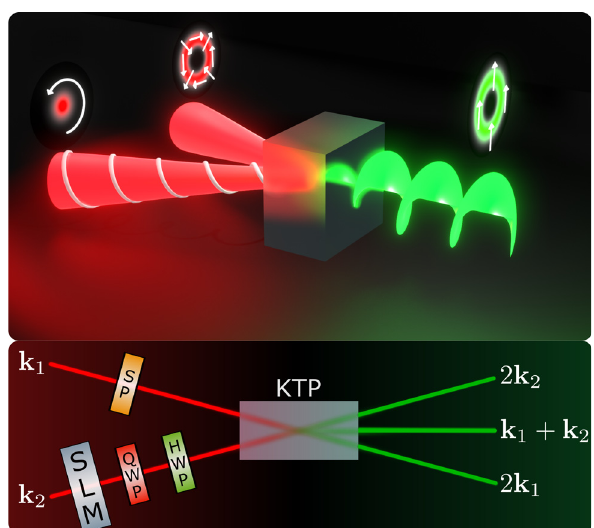
Figure 1: Experimental scheme for spin–orbit angular momentum transfer in second harmonic generation. SP: S-plate for generation of the vector-vortex beam. SLM: spatial light modulator. QWP: Quarter waveplate. HWP: half waveplate. KTP: potassium titanyl phosphate (KTiOPO4)